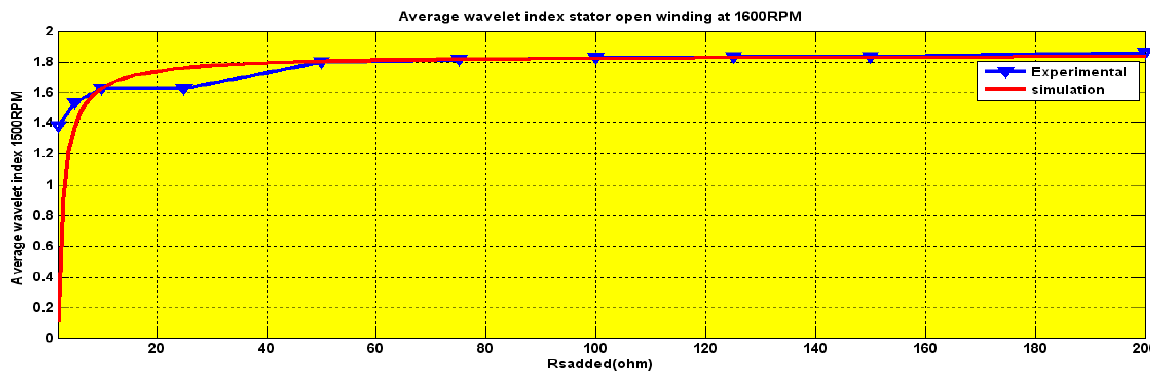
Figure 22. Wavelet index for series Rs (2–200) Ohm at 1,600 rpm.